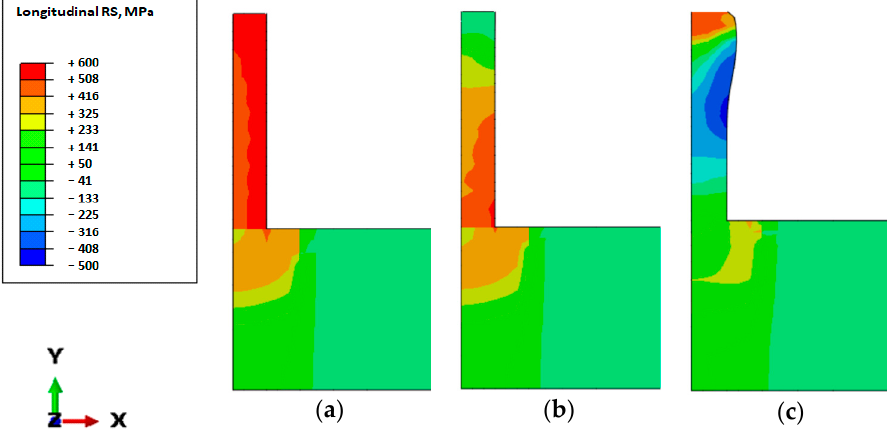
Figure 16. Longitudinal RS distributions: ( a ) prior to rolling; ( b ) after rolling at a load of 10 kN; ( c ) after rolling at a load of 50